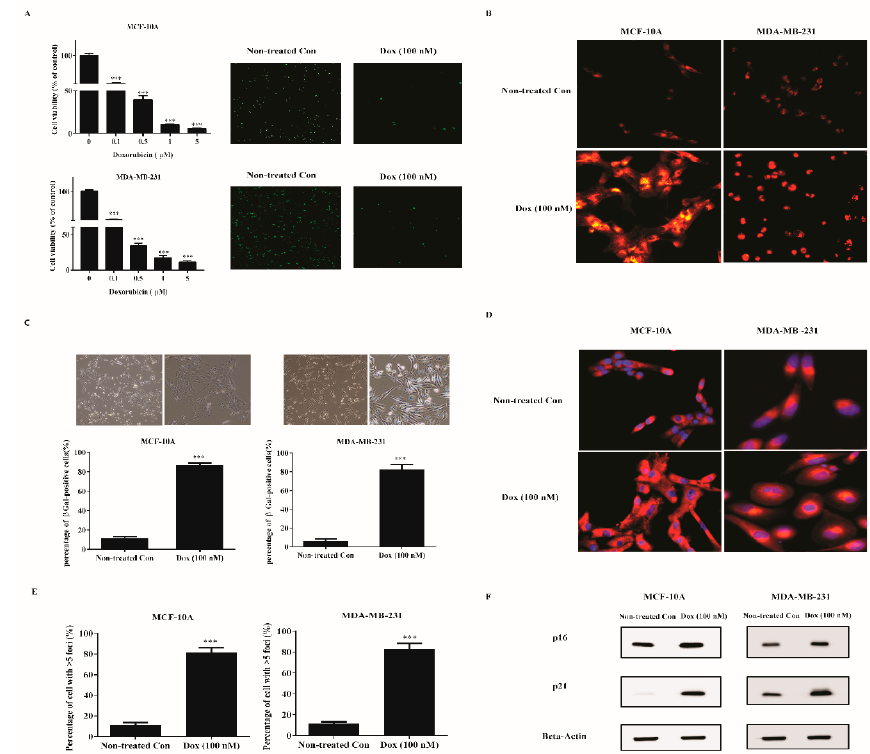
Figure 1. Doxorubicin induces senescence of breast normal and cancer cells. ( A ) MDA-MB-231 cells and MCF-10A cells were treated with indicated doses of doxorubicin for 72 h. Cells were either assayed for viability (left panel) or fixed and stained for Ki-67 (right panel, green). Cell viability was determined by WST-1 method and normalized with nontreated con cells. ( B – D ) Cells were treated with 100 nM doxorubicin for 72 h to induce senescence. Then, cells ( B ) were incubated with Lysotracker Red (200 nM) for 1 h. Cells ( C ) were fixed and stained for SA- β -gal. The upper panel shows the bright-field images. The lower panel was the percentage of positive cells (>200 cells scored). Cells ( D ) were incubated with Mitotracker Red (100 nM) for 30 min. Blue, DAPI stained nuclear. Representative images were captured by a Fluorescence Microscope (100× for A and C ; 200× for ( B ) and ( D ). ( E ) Then days after senescence induction, nontreated con and senescent cells were immunostained with 53BP1, a DNA-SCAR marker. The number of the foci was determined by CellProfiler. Shown was the percentage of cells with >5 foci. ( F ) Extracts from nontreated con and senescent cells were measured for the indicated proteins by western blotting. Beta-actin was used as the loading control. *** indicates p < 0.001 versus nontreated con.